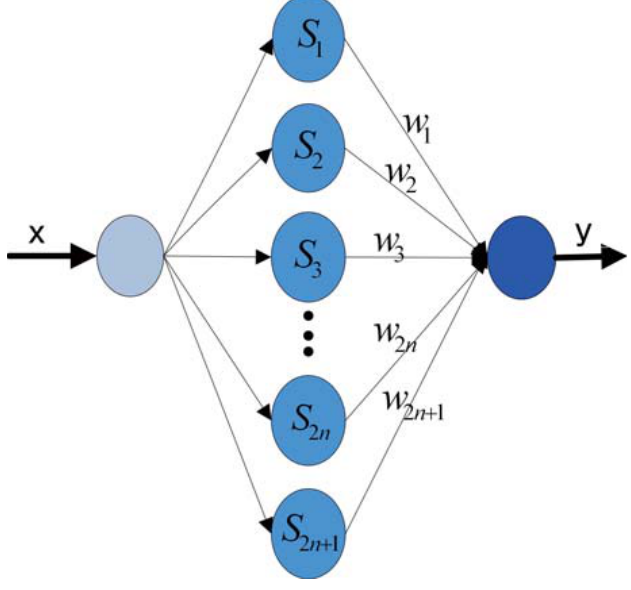
Figure 1. The typical structure of the Fourier neural network